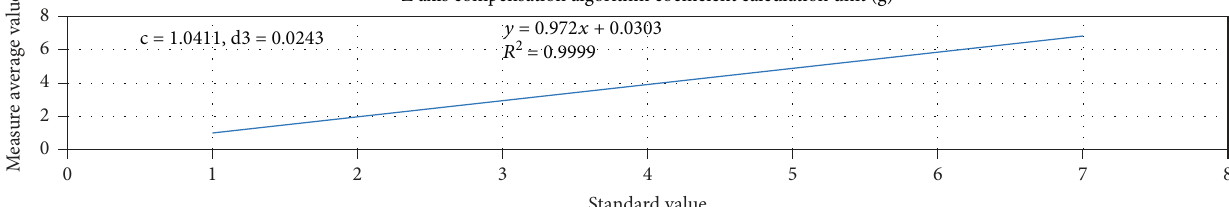
Z axis compensation algorithm coefficient calculation unit (g)